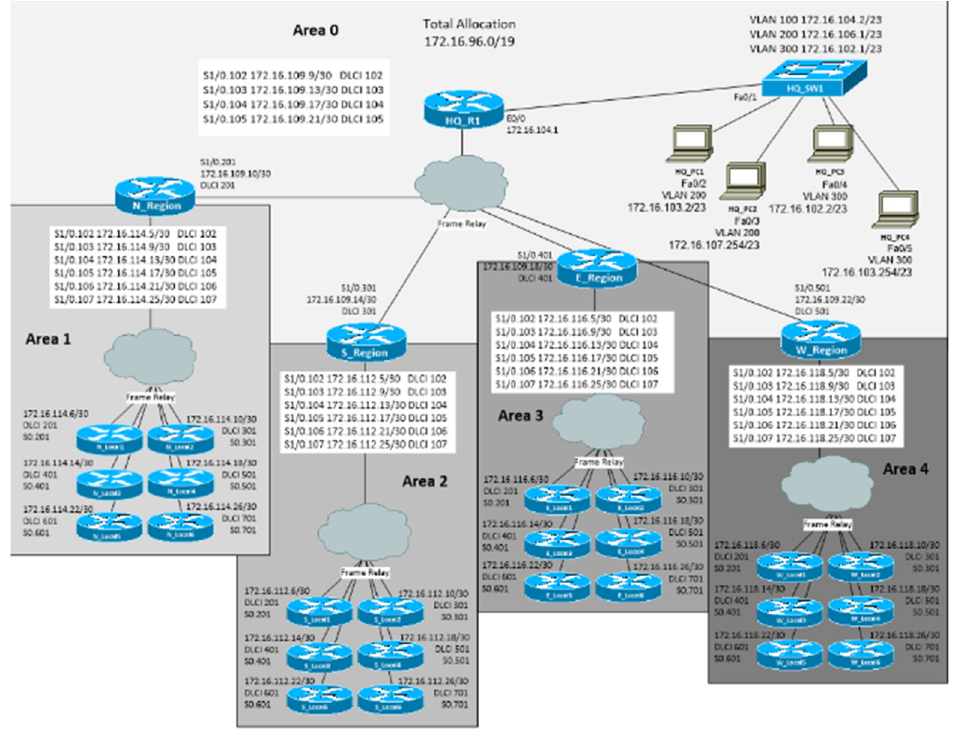
Figure 5. Illustration of NetSIM Lab experimental environment for connection of routers for multi- area access enabling the areas of cloud computing (Source: [137,138]).